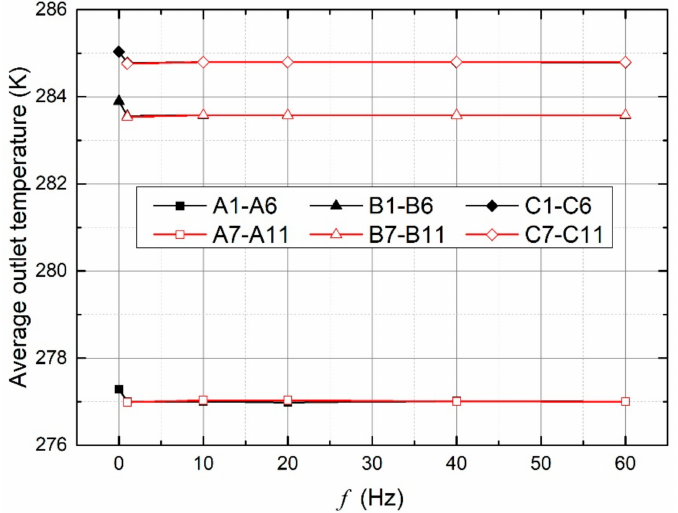
Figure 9. Average outlet temperature under di ff erent